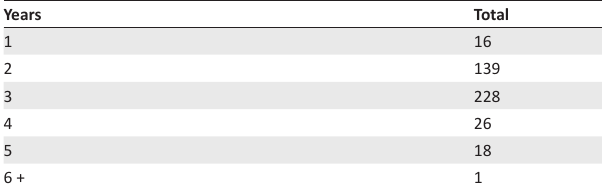
TABLE 3b: The respondents’ number of years worked for the